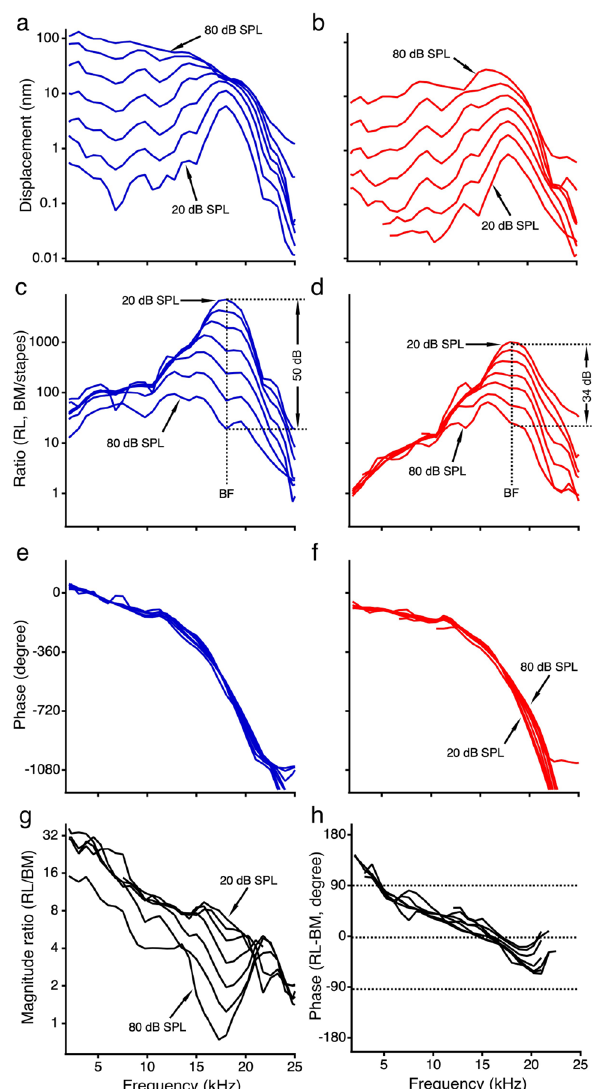
Figure 2. The reticular lamina and basilar membrane vibrations measured from a different sensitive cochlea. The RL and BM magnitude ( a , b ) and phase ( e , f ) responses, magnitude transfer functions ( c , d ), and the magnitude and phase differences between the RL and BM vibration ( g , h ) are similar to panels ( c – j ) in Fig.